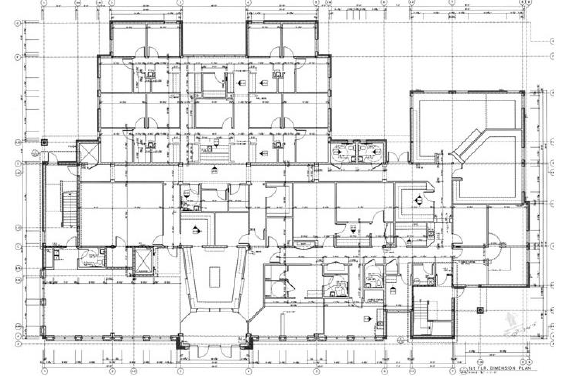
Figure 6. Example of existing as built drawing that need to transform into digital GIS format with attribute insertion.